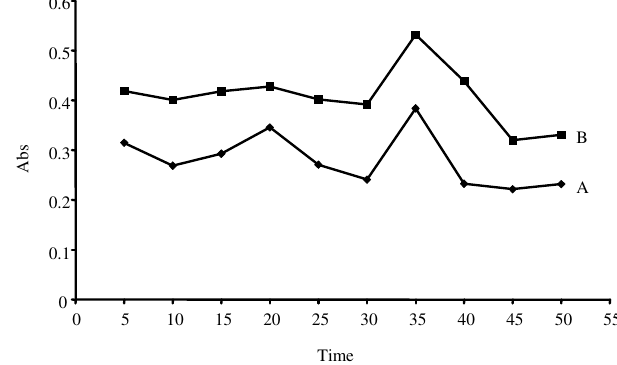
Figure 8. Adsorption capacity against contact time of dyes A and B with